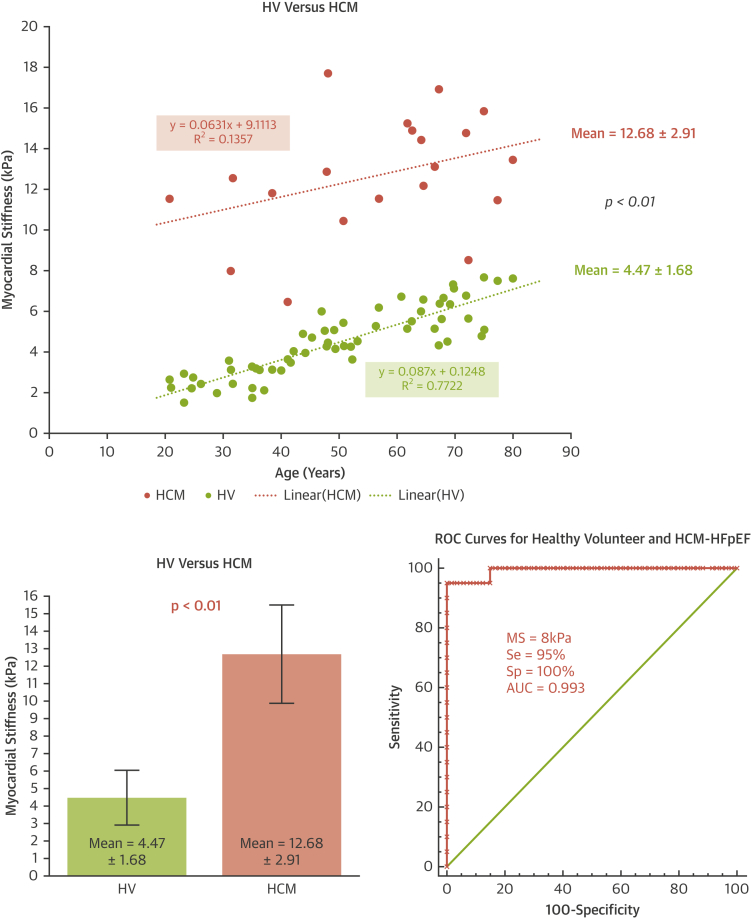
Myocardial Stiffness in HCM and HV GroupsComparison of Myocardial Stiffness between healthy volunteer group (HV) and hypertrophic cardiomyopathy with HFpEF group (HCM group). AUC = area under the curve; MS = myocardial stiffness; ROC = receiver-operating curve; Se = sensitivity; Sp = specificity; other abbreviations as in Figures 1 and 2.